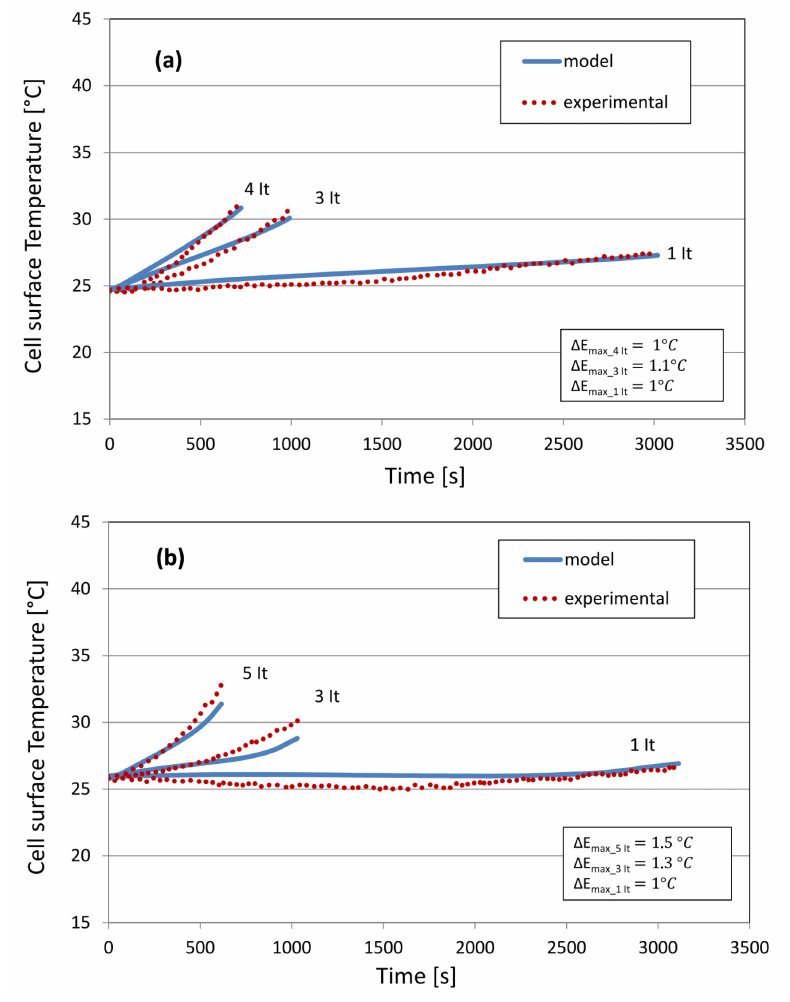
Figure 5. Surface temperature evolution of the cell with an homogeneous internal region during: ( a ) charge and ( b )